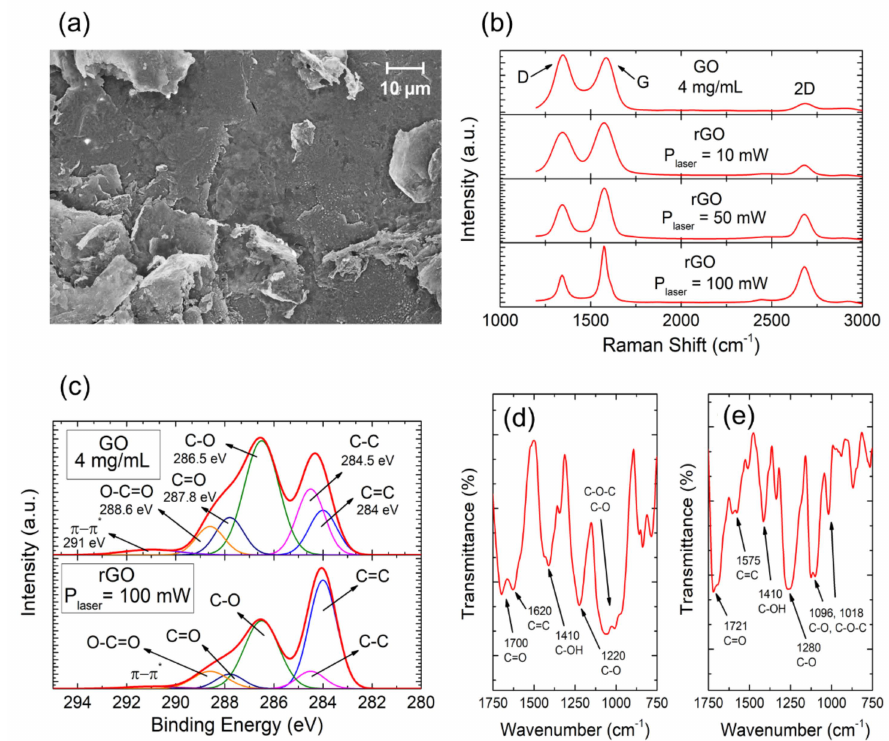
Figure 2. Structural characterization. ( a ) SEM image of laser-reduced graphene oxide at 70 mW (initial GO colloid concentration 0.5 mL / cm 2 ). ( b ) Raman spectra acquired from the GO film before and after the laser-assisted reduction for di ff erent laser powers. ( c ) Comparison of the C1s peak from the XPS spectrum of both GO (top) and laser-reduced GO (bottom) samples. ( d ) ATR-FTIR spectra of unreduced GO. ( e ) ATR-FTIR spectra of 100 mW laser-reduced